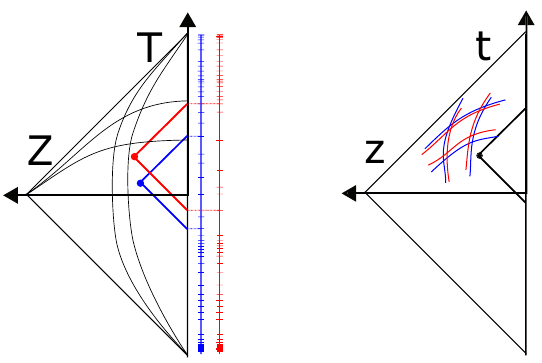
Figure 1 . Left: building the bulk frame from the Poincar´e perspective ( T, Z ). For two reparametrizations (blue and red), we construct the bulk point given two boundary observer time coordinates t and t . The ticks in the clock-ticking pattern are depicted. The bulk location is 1 2 fuzzy in the Poincar´e geometry, but the metric is fixed. Right: building the bulk frame from the observer’s perspective ( t, z ). The bulk location is fixed, but the metric